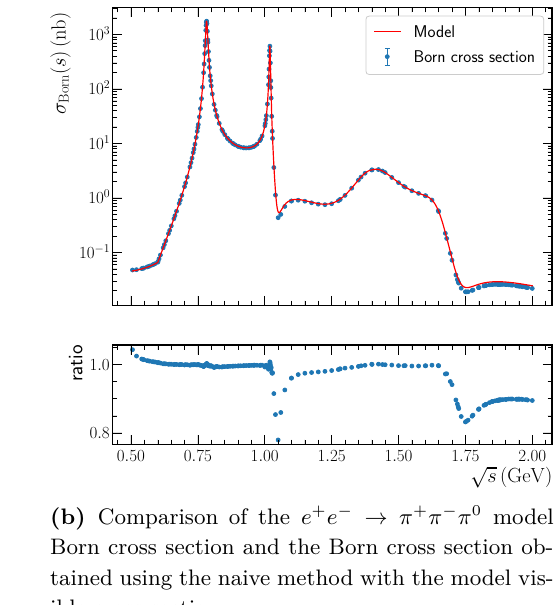
(b) Comparison of the e + e − → π + π − π 0 model Born cross section and the Born cross section ob- tained using the naive method with the model vis- ible cross section.